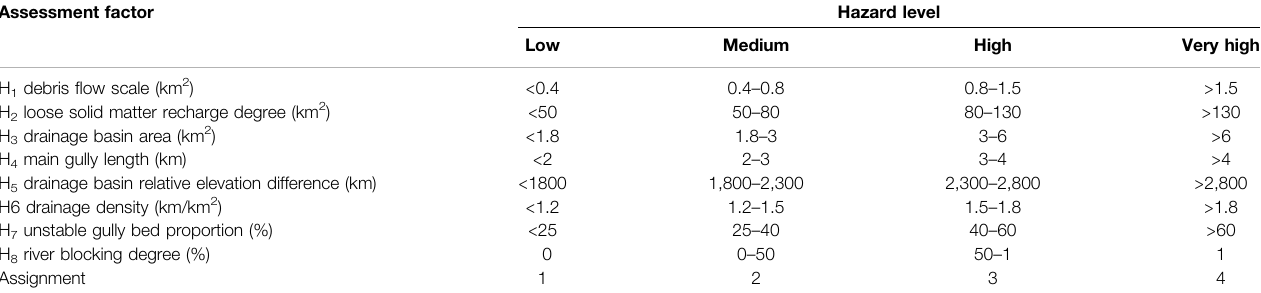
TABLE 2 | Assessment factors and levels of debris fl ow hazards.